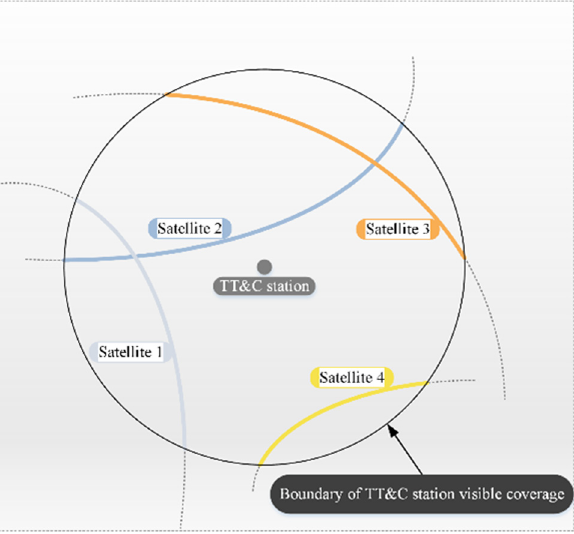
Figure 8: Flight path schematic diagram of four satellites in visible coverage.